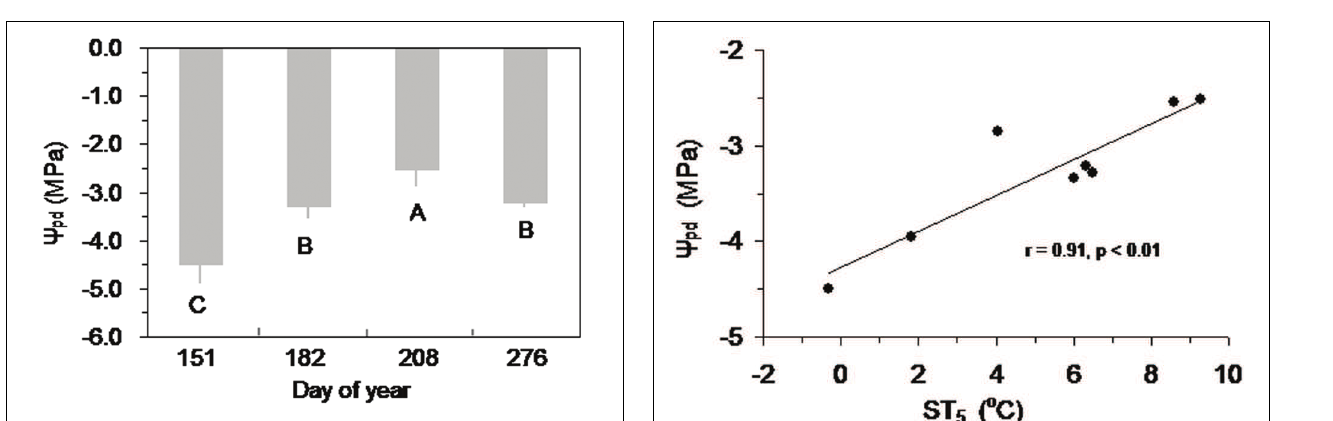
FIGURE 8 | Predawn leaf water potential ( (cid:57) pd ) of Smith fir trees at the sub-alpine and treeline sites as a function of mean soil temperature at 5 cm (ST 5 ) during the growing